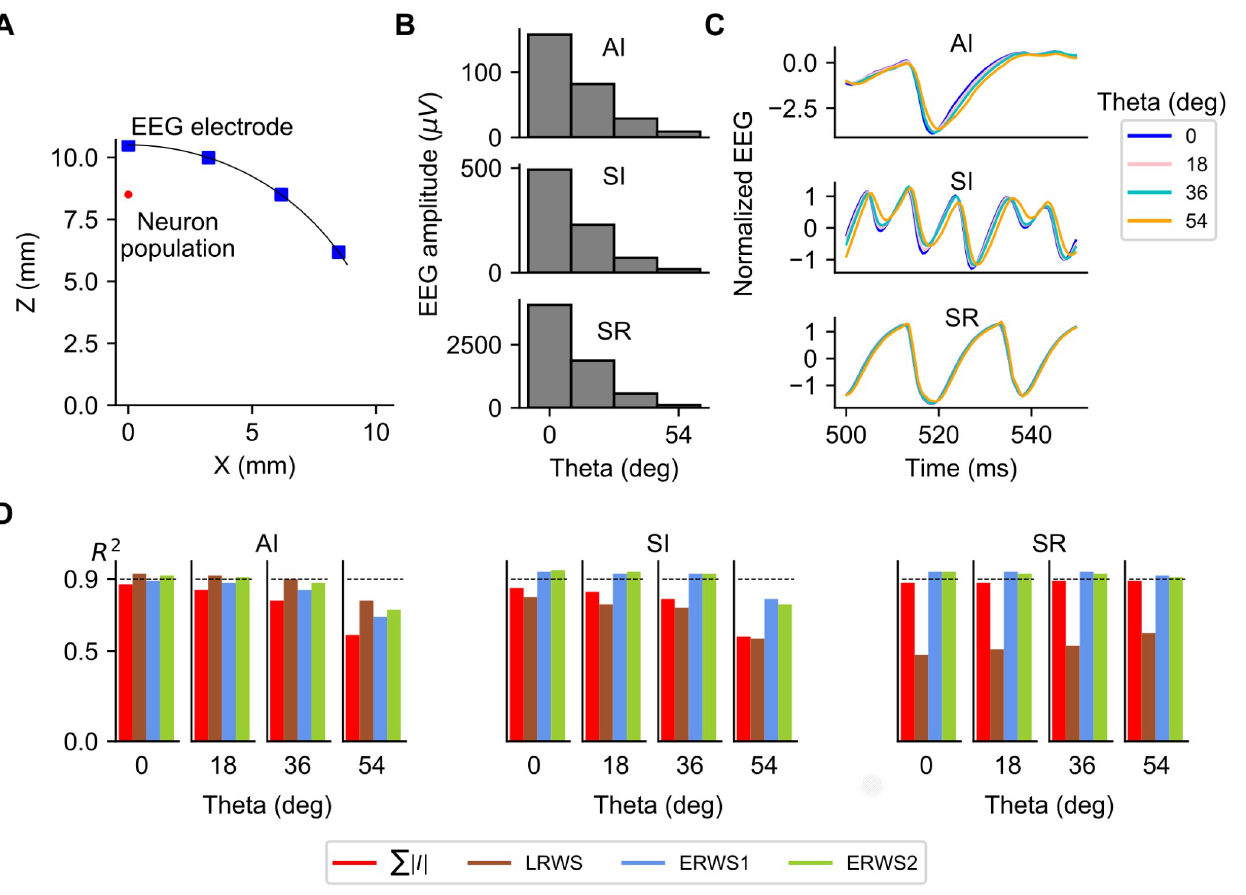
Fig 6. EEG and proxies as a function of the position of the electrode over the head model. (A) Illustration of the scalp layer in the four-sphere head model and locations where the EEG is computed. Location of the center of soma positions of the multicompartment neurons is marked as “Neuron population”. (B) EEG amplitude, (C) normalized EEG and (D) performance of ∑ | I |, LRWS , ERWS1 and ERWS2 as a function of the angle between the electrode location and the Z-axis (angle Theta), computed for the three different network states: AI, SI and SR.